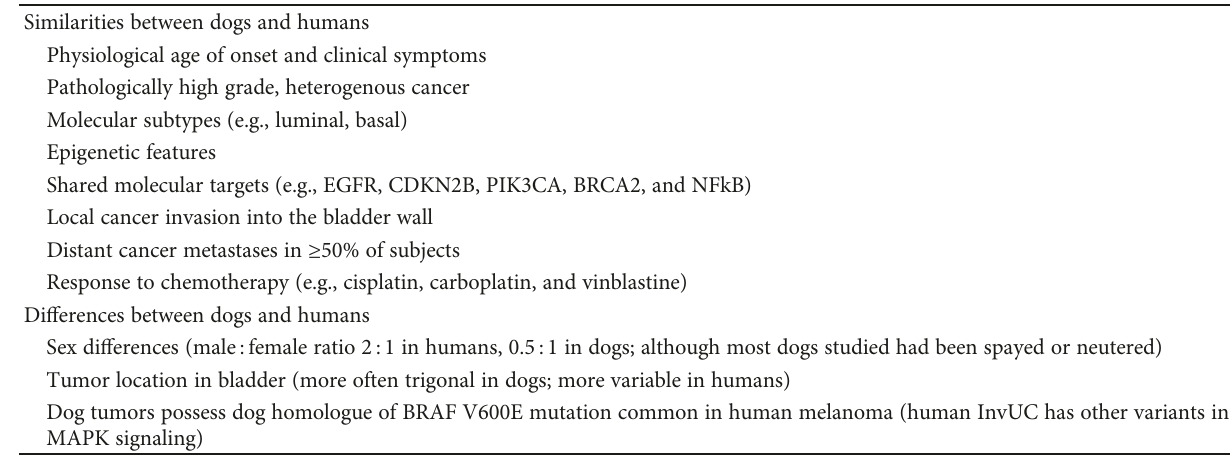
Table 1: Similarities and di ff erences in naturally occurring invasive urothelial carcinoma between dogs and humans. Similarities between dogs and humans Physiological age of onset and clinical symptoms Pathologically high grade, heterogenous cancer Molecular subtypes (e.g., luminal, basal) Epigenetic features Local cancer invasion into the bladder